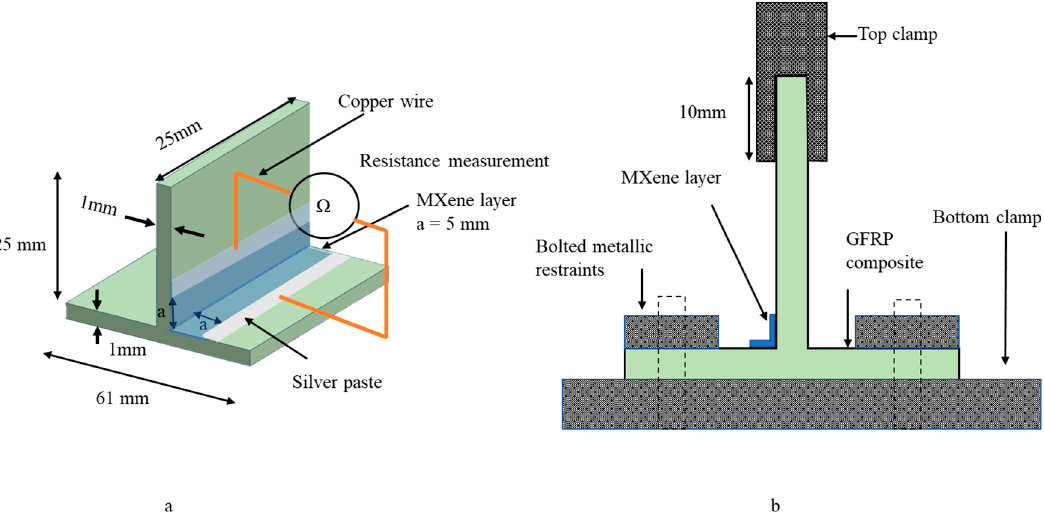
Figure 3. Three-dimensional woven composite T-profile: ( a ) specimen dimensions; ( b ) experimental setup for tensile and fatigue loading.